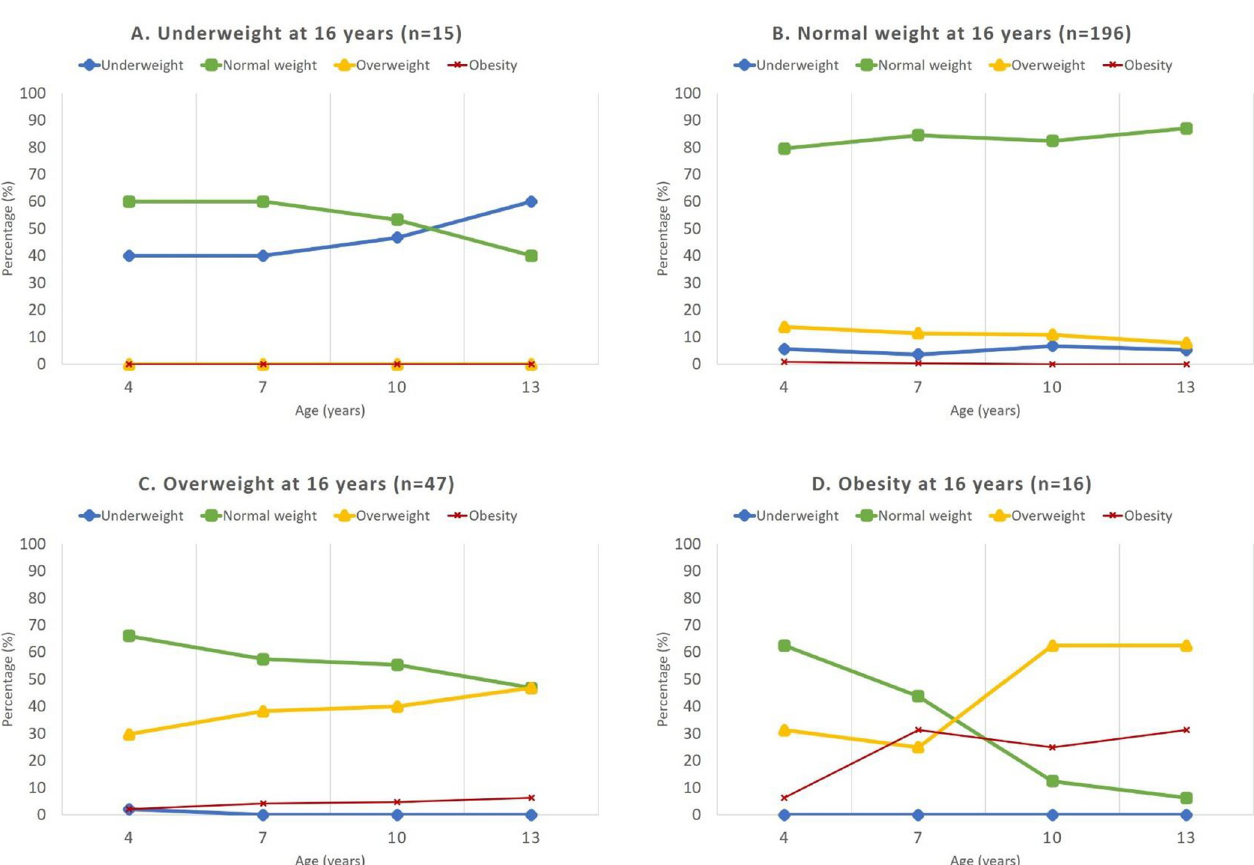
Fig 3. Development of weight class according to the isoBMI classification from early childhood to adolescence for children born 1999–2000 in Lidko¨ping, divided into the weight class at 16 years; underweight (A), normal weight (B), overweight (C) and obesity